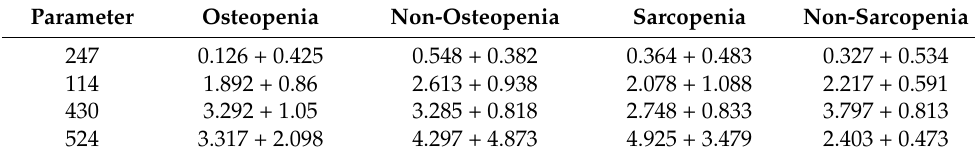
Table 14. Top 2 descriptive statistical parameters of osteopenia and sarcopenia. Parameter